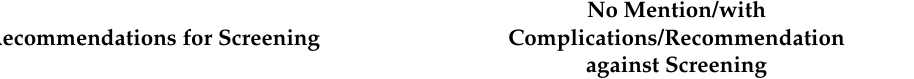
Table 4. Median Year of Publication for Conflicting